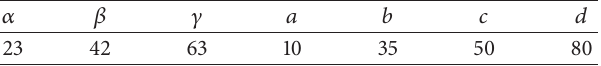
Table 2: Values of fixed variables (unit of money). Table 3: Values of constant coefficients.